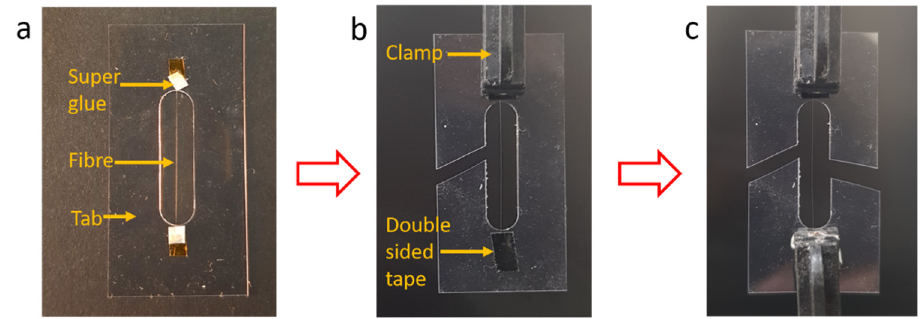
Figure A1. Single fibre test sample preparation and testing . ( a ) Fibre glued to plastic tab with super glue. ( b ) Double-sided tape is applied on top of glue and one side of tab cut before loading into clamps of the Instron. ( c ) Second side of tab cut so that fibre is free standing.